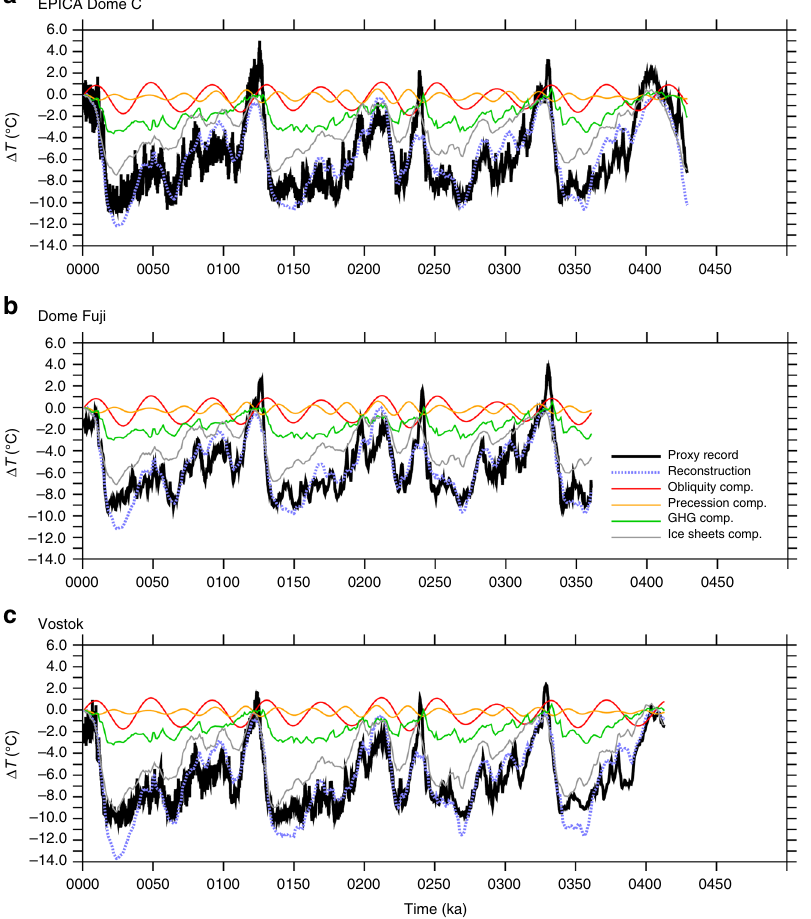
Fig. 2 Temperature signals in ice cores and annual mean linear reconstructions. Temperatures over the past several glacial cycles from ice cores (black) and GFDL CM2.1 annual mean model-based linear reconstructions (dashed blue) for a EPICA Dome C, b Dome Fuji, and c Vostok. The model-based linear reconstruction is the sum of contributions from obliquity (red), precession (orange), greenhouse gases (green), and ice sheets (gray). Reconstruction Δ T is plotted relative to 1 ka and the proxy records are plotted with the same mean value as the